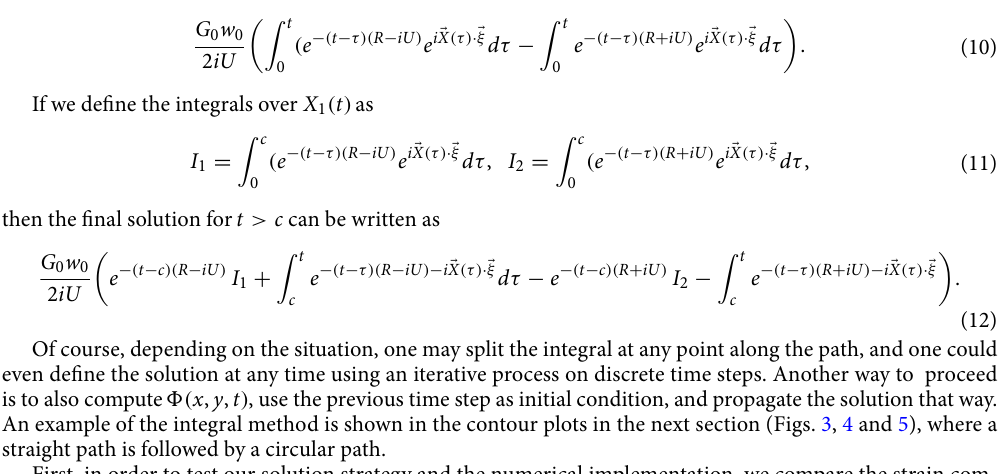
0.17 m over a fluid = 6.5 s. Right panel shows the = 19 =